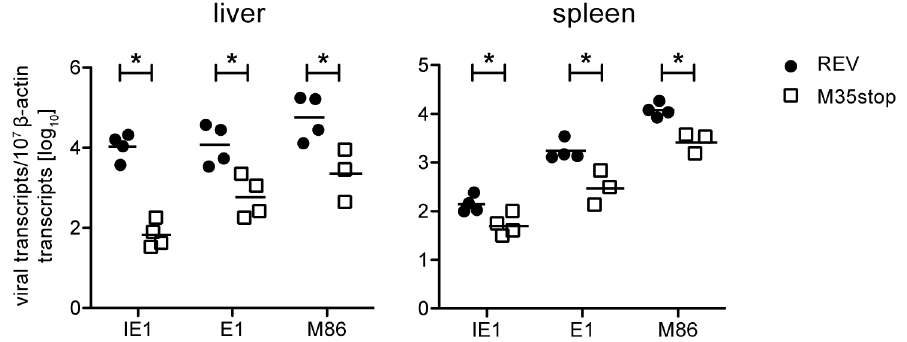
Fig 10. Infection with MCMV lacking M35 leads to lower levels of viral transcripts in vivo . BALB/c mice were infected i.v. with 2 x 10 5 PFU MCMV-M35stop-REV (REV, black circle) or MCMV-M35-stop (M35stop, open square). Expression of viral transcripts in liver and spleen was quantitated 24 hours p.i. by quantitative RT-PCR specific for m123/IE1, m112/E1 and M86/MCP. Data were normalized to 10 7 cellular β -actin transcripts. * p <